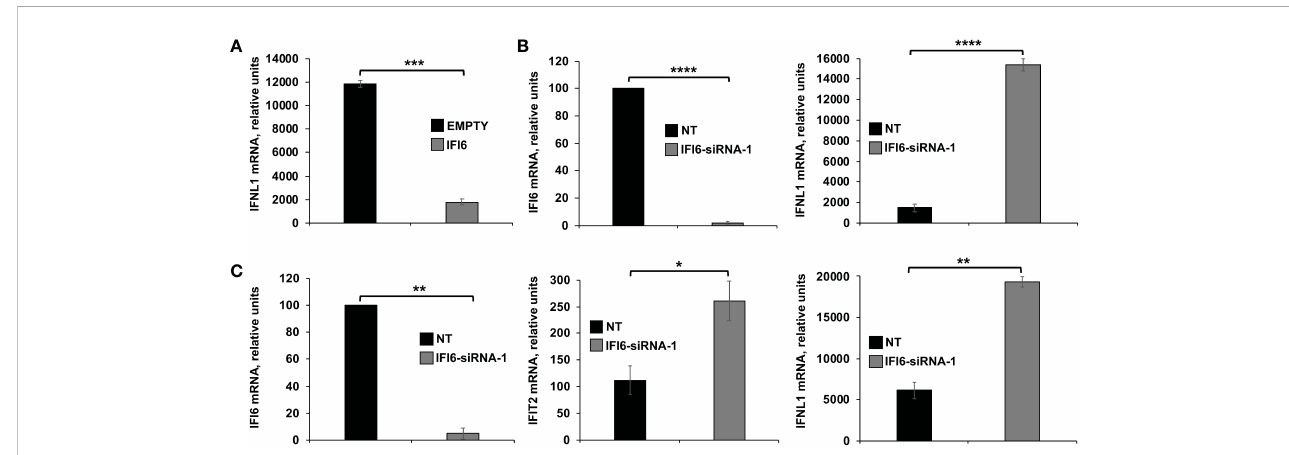
FIGURE 6 Effect of IFI6 on the modulation of innate immune responses induced in epithelial cells. Effect of IFI6 overexpression. (A) Human 293T cells were transfected with a plasmid expressing IFI6 (pCAGGS-IFI6-HA) or with the empty plasmid as control. Effect of IFI6 silencing. (B, C) Alternatively, 293T (B) and BEAS-2B (C) cells were transfected with the IFI6 siRNA or with the NT siRNA as control. (A – C) At 24 hpt, the cells were infected with SeV for an additional 24 h. The levels of IFI6 (B, C) , IFNL1 (A – C) and IFIT2 (C) expression were measured by RT-qPCR and mRNA levels were expressed as fold change (increases) in comparison to mock-treated cells, used as controls. Three different experiments were performed, with similar results. *P<0.05, **P<0.01, ***P<0.001, ****P<0.0001 (using Student ’ s t